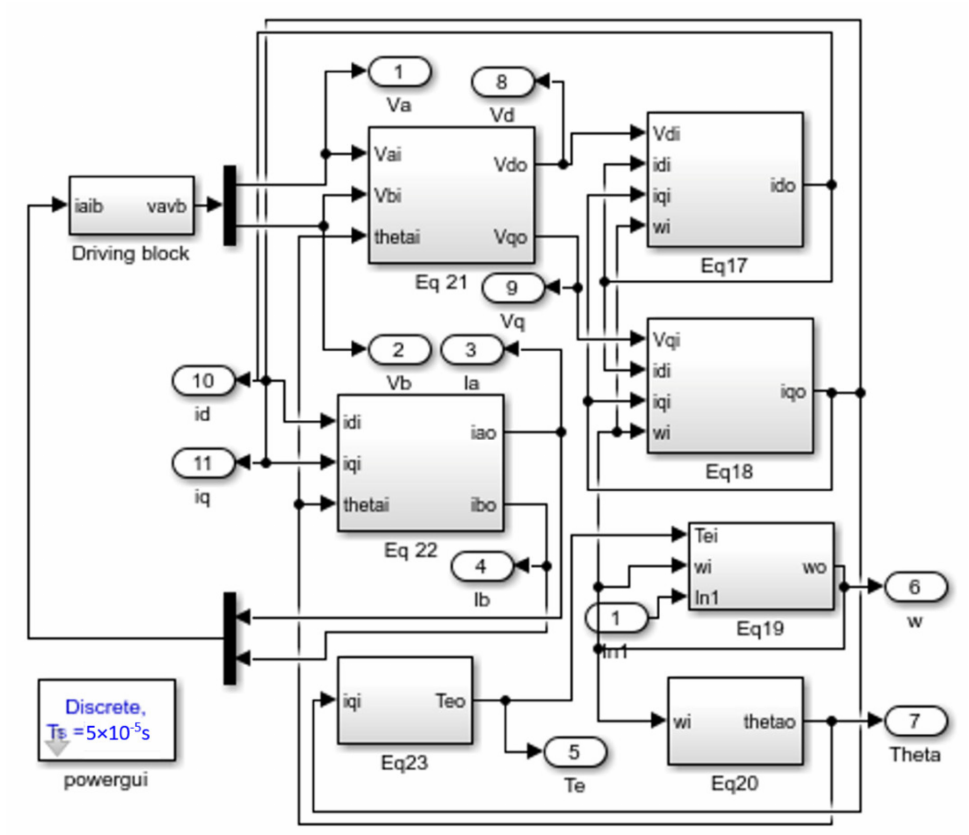
Figure 4. Proposed Simulink model of two-phase Hybrid Stepper Motor.